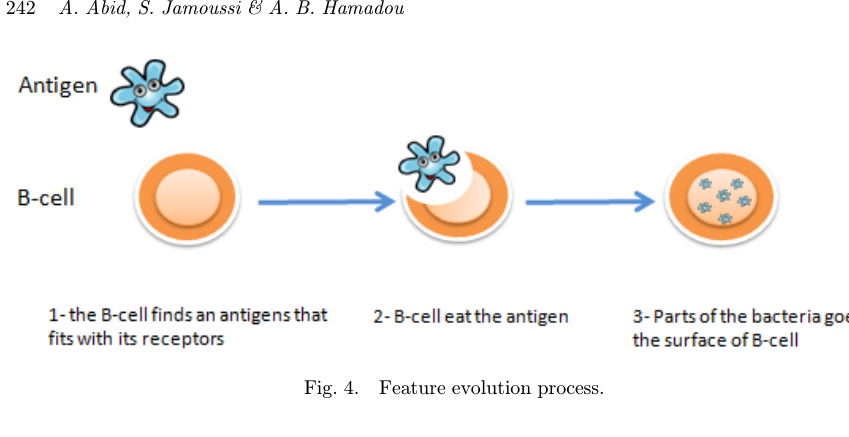
Fig. 4. Feature evolution